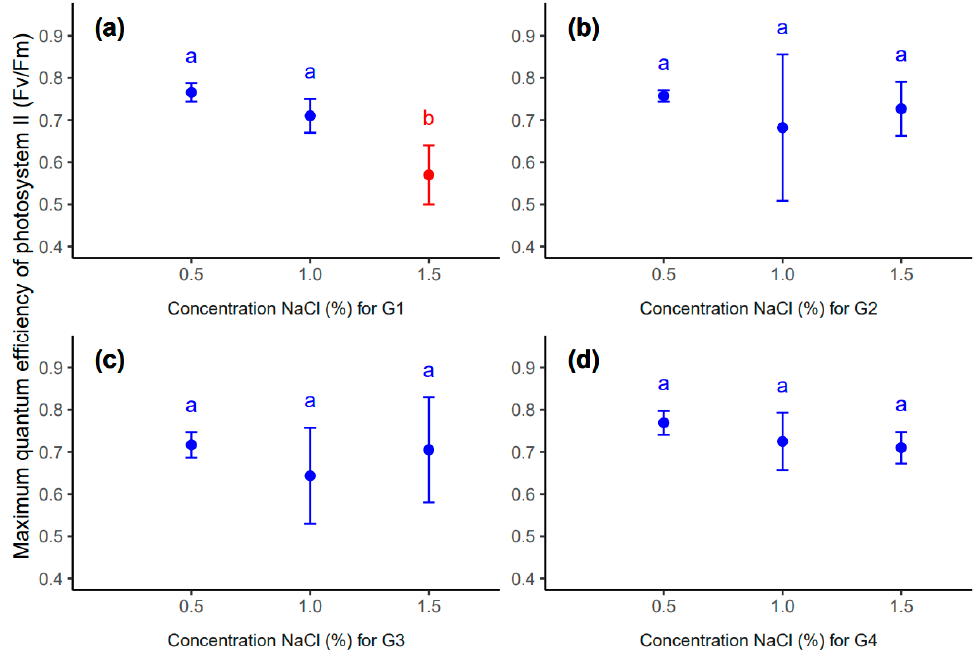
Figure 7. Mean value (point) and standard deviation (error bar) for genotype: G1 ( a ), G2 ( b ), G3 ( c ) and G4 ( d ) in different concentrations of NaCl: 0.5, 1.0, 1.5 (%). The same letters inside each subplot indicate the lack of statistically significant differences between means ( p < 0.05).